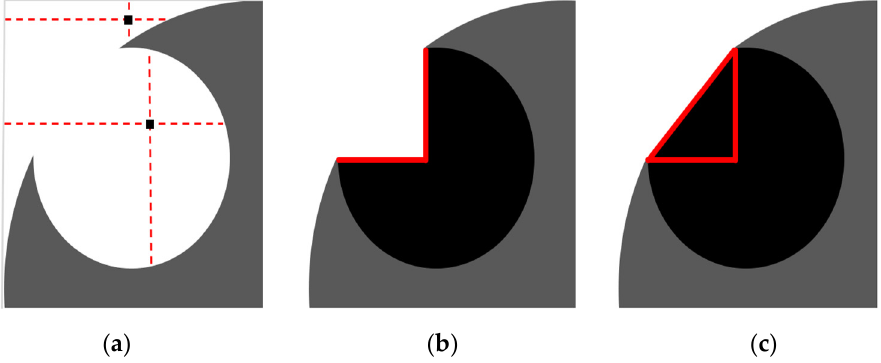
Figure 6. Image sequence of the proposed filtering procedure used to determine the outer shape of the APM foam elements.